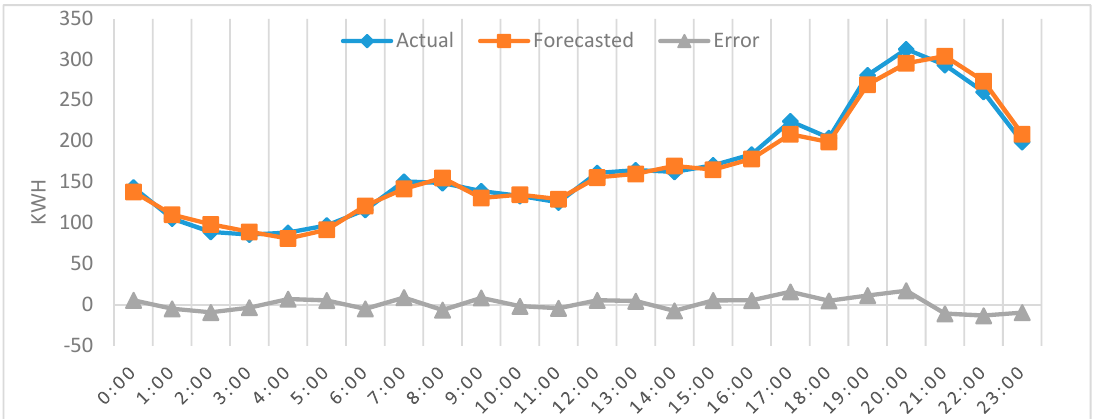
Figure 16. Load forecasted values versus actual consumption for profile P_III.1.